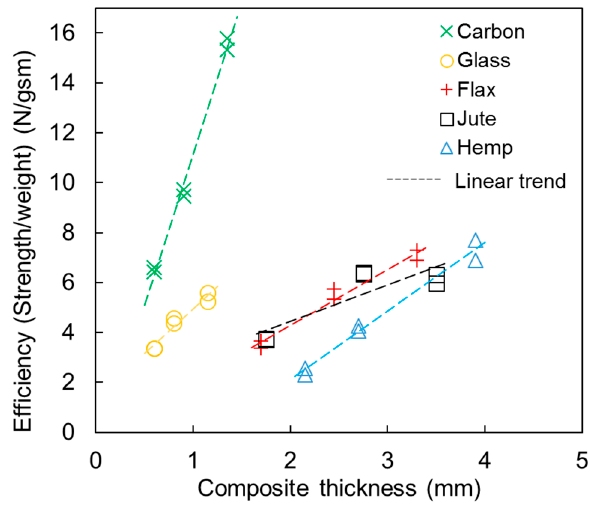
Figure 9. Composite channel compression strength efficiency (strength per fiber mass, N/gsm).